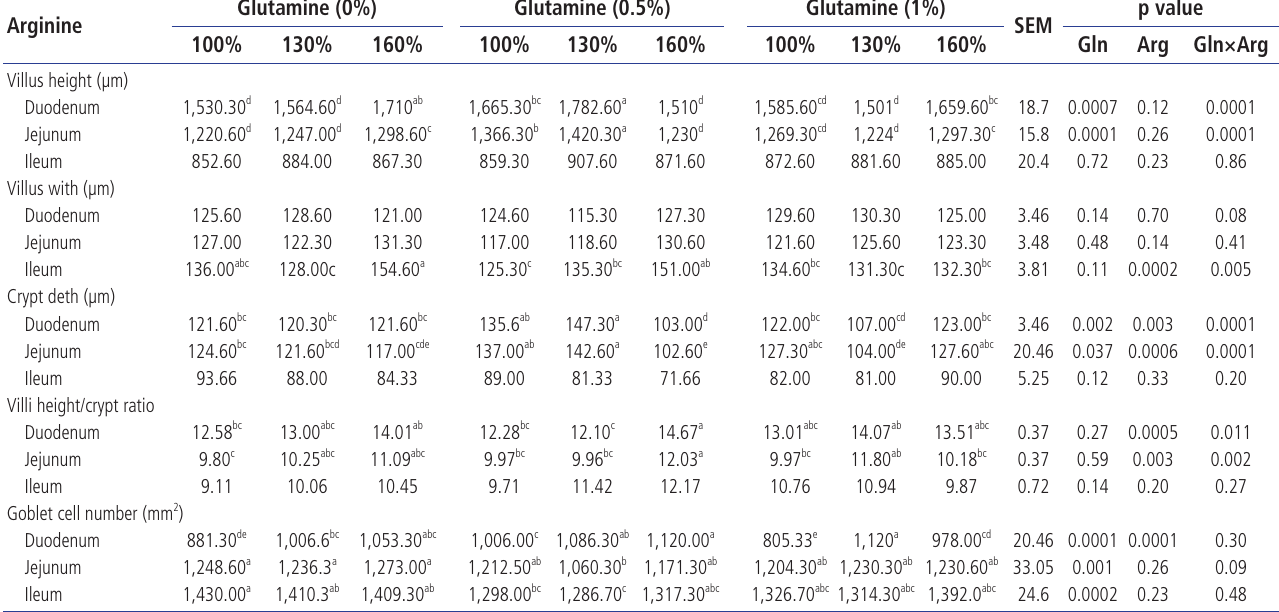
Table 5. The effects of dietary supplementation with glutamine (Gln) and arginine (Arg) on villus height, villus width, crypt depth, villus height/crypt depth ratio and goblet cell number (GCN) in small intestine of broiler reared under cold environmental condition Glutamine (0%) Glutamine Arginine